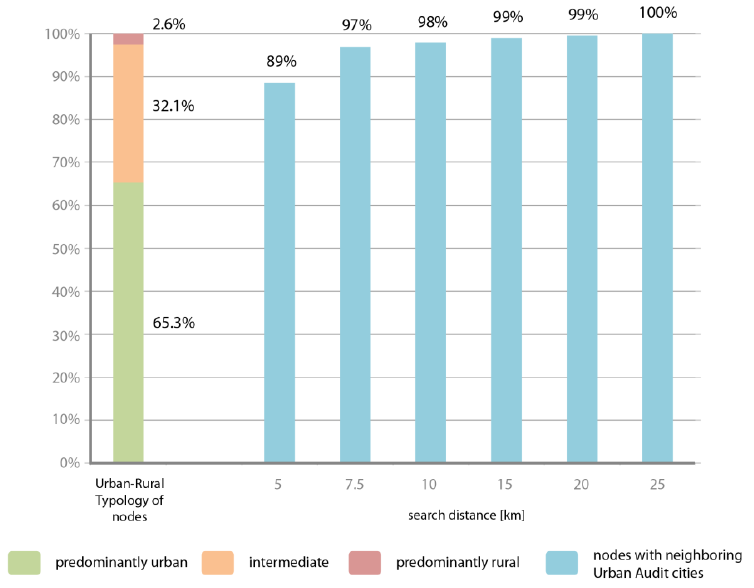
Figure 5. Plausibilization of detected nodes in relation to the Urban-Rural Typology and Urban Audit cities.